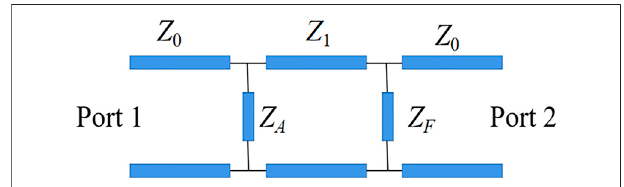
FIGURE 1 | Two-port network of